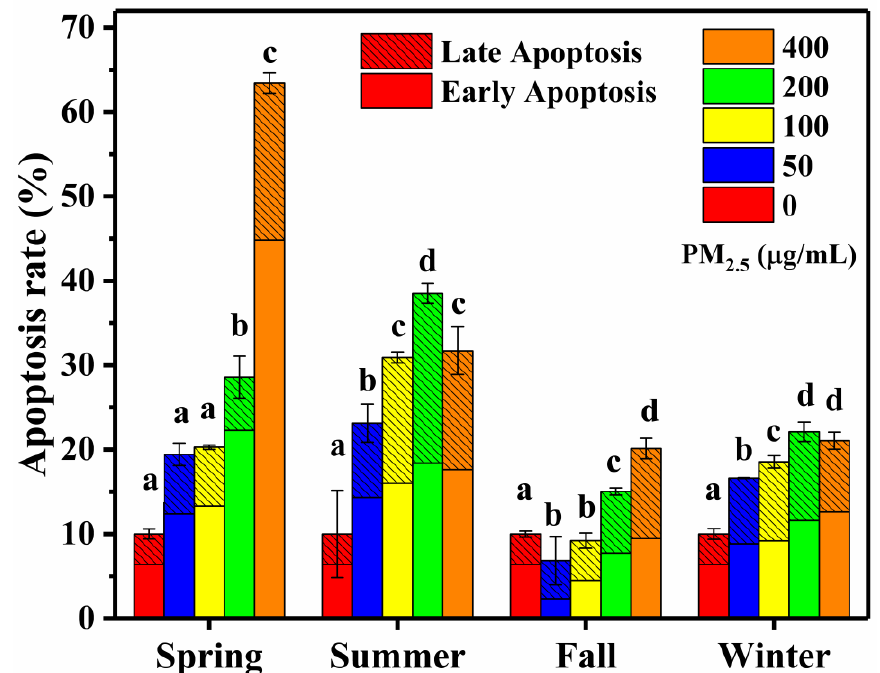
Figure 7. Representative cross quadrant images of Annexin V-FITC/PI double staining determined by flow cytometry (the summer sample).